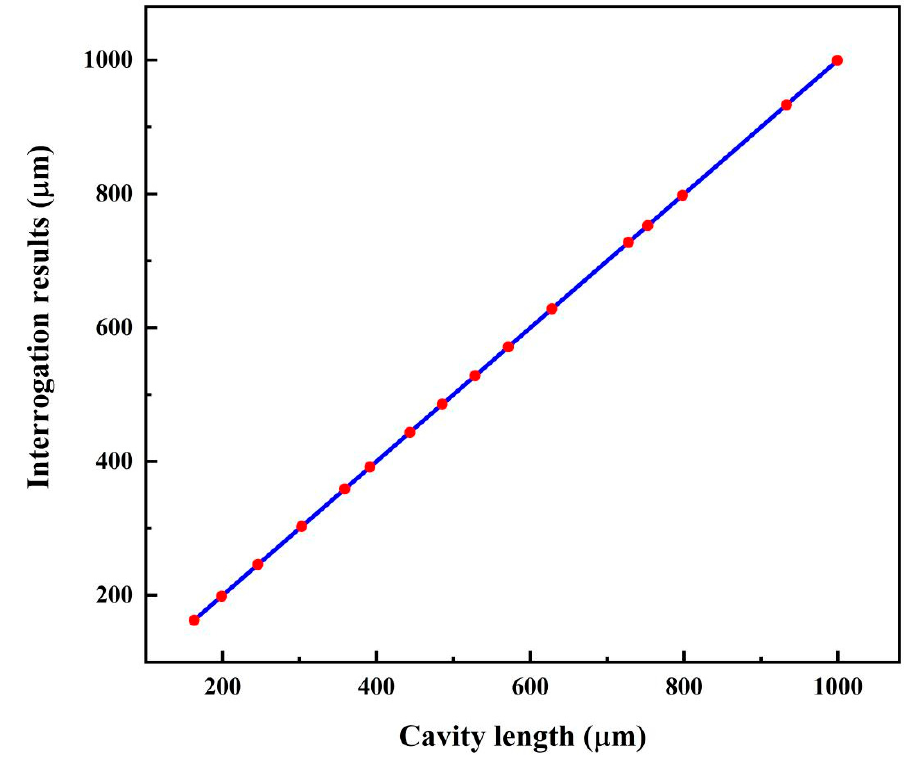
Figure 13. Cavity length interrogation results for fiber-optic FP sensors with different cavity lengths in the range of 150–1000 μ m